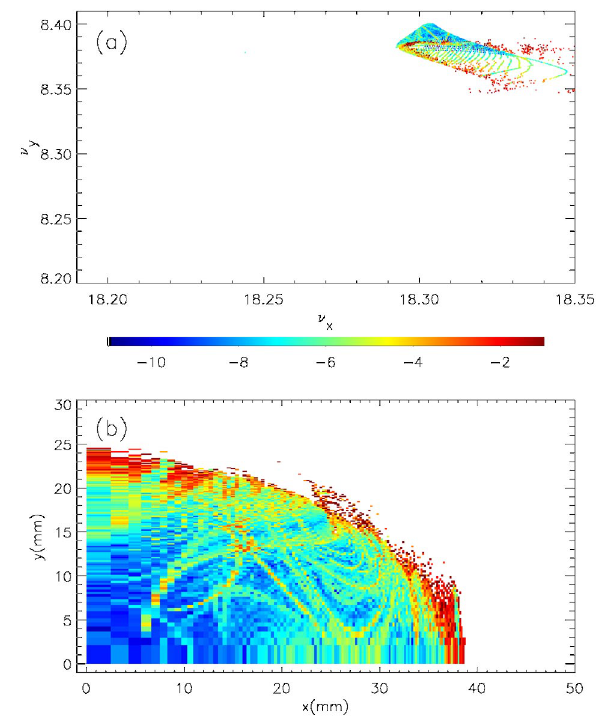
FIG. 8. (Color) SOLEIL second optics: Frequency map (a) and dynamic aperture (b) for the Poincare´ surface s (cid:1) 0 ( (cid:28) (cid:1) 8 m ). 10 m and (cid:28) y